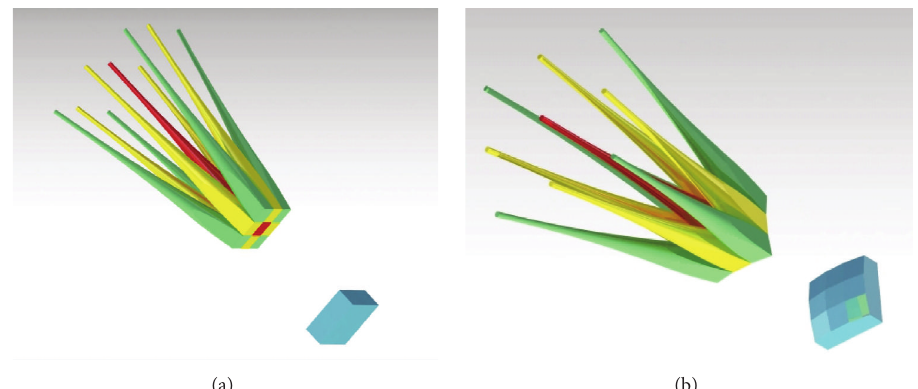
Figure 2: Assembly of coupler: (a) concept of flat plate and (b) concept of carved